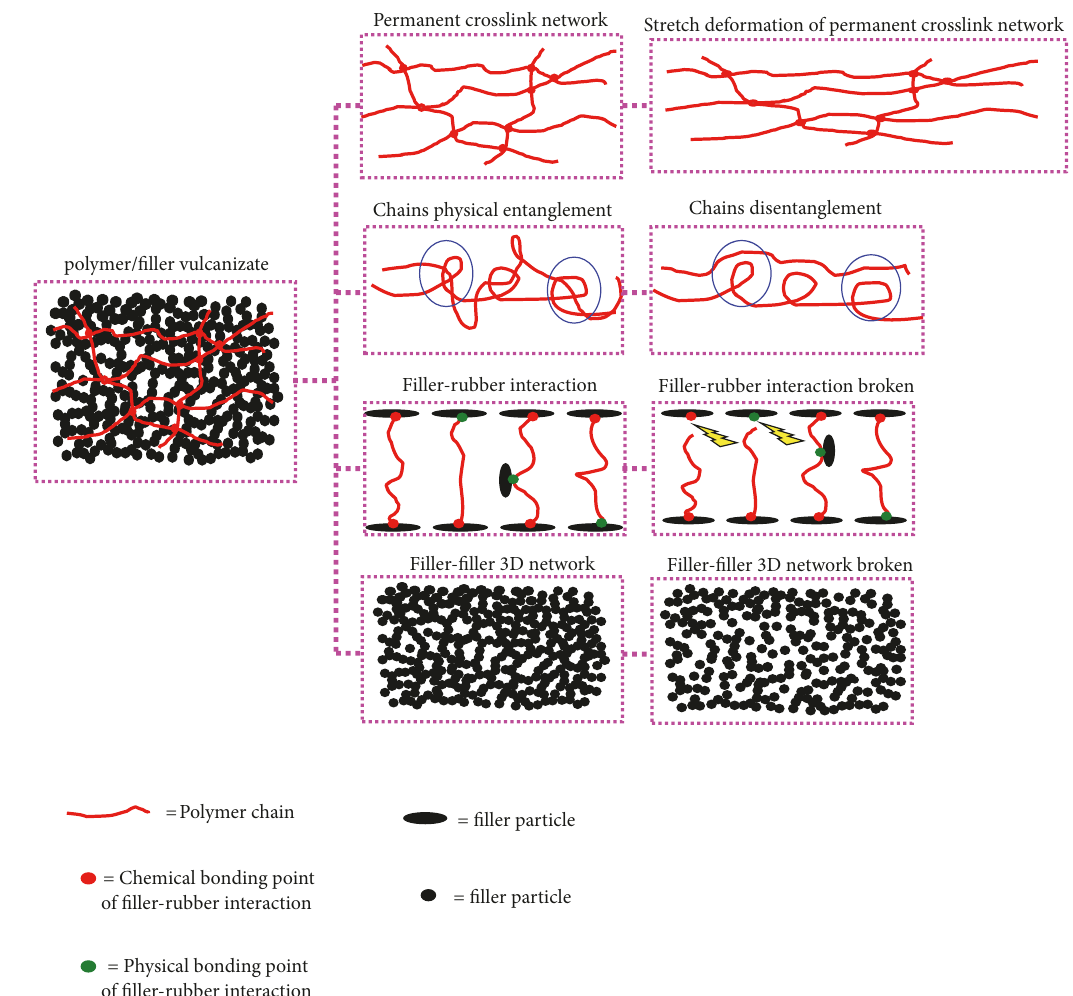
Figure 7: Filler reinforcement and Mullins effect